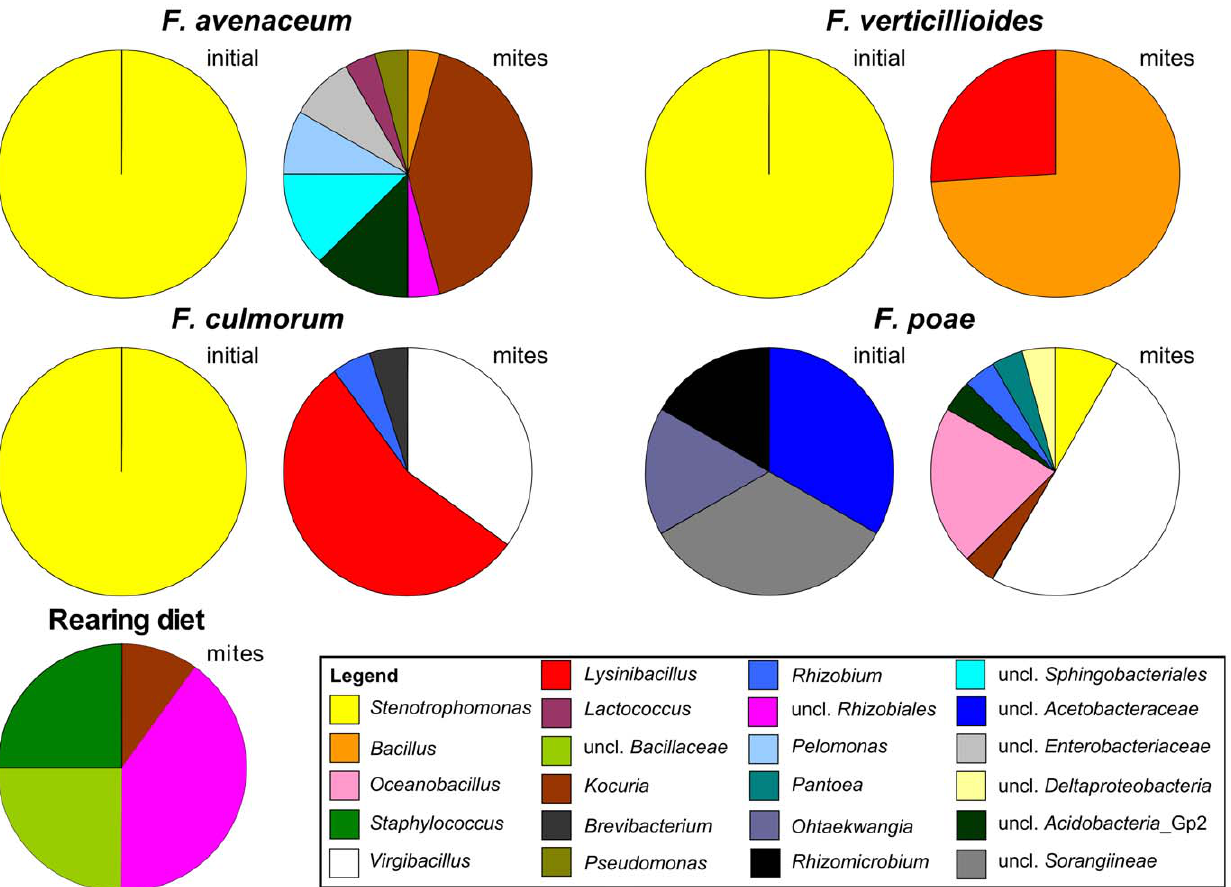
Figure 1. Phylogenetic assignment of bacterial 16 S rRNA gene sequences cloned from DNA extracted from Tyrophagus putrescentiae and Fusarium sp., cultures. Samples of T. putrescentiae shifted from rearing diet to Fusarium spp. diet are labelled as mites. The bacterial community associated with Fusarium culture before mite introduction is labelled as initial.